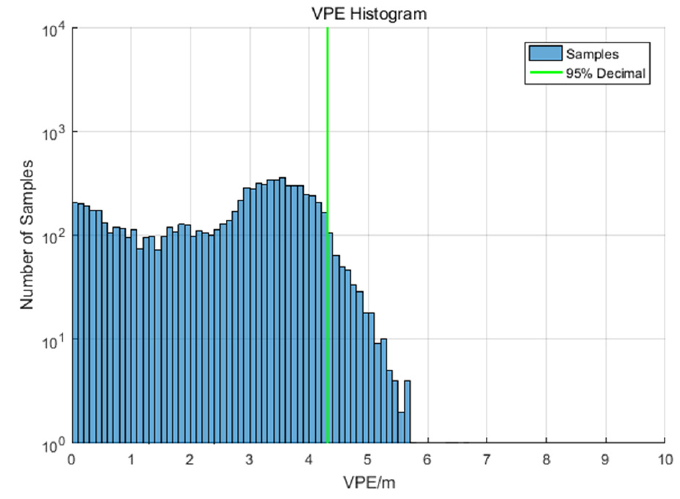
Figure 16. The VPE histogram of flight test-II. The green line in the figure is the vertical accuracy (95%), which is 4.30 m.